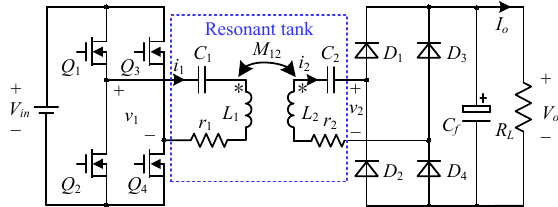
Figure 1. S/S compensated converter.